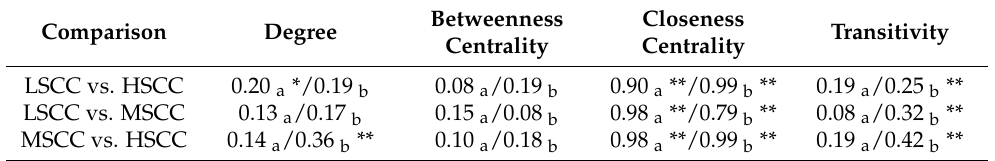
Table 2. Kolmogorov–Smirnov test of each microbial network topological parameter in two sites. Betweenness Closeness Transitivity Comparison Degree Centrality Centrality LSCC vs. HSCC 0.20 a */0.19 b 0.08 a /0.19 b 0.90 a **/0.99 b ** 0.19 a /0.25 b ** LSCC vs. MSCC 0.13 a /0.17 b 0.15 a /0.08 b 0.98 a **/0.79 b ** 0.08 a /0.32 b ** MSCC vs. HSCC 0.14 a /0.36 b ** 0.10 a /0.18 b 0.98 a **/0.99 b ** 0.19 a /0.42 b